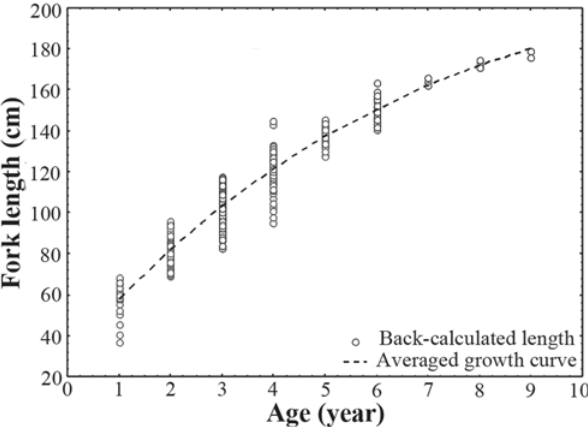
Fig. 5. Averaged model fitted to back-calculated length-at- age data for both sexes of the bigeye tuna, T. obesus , in the Atlantic